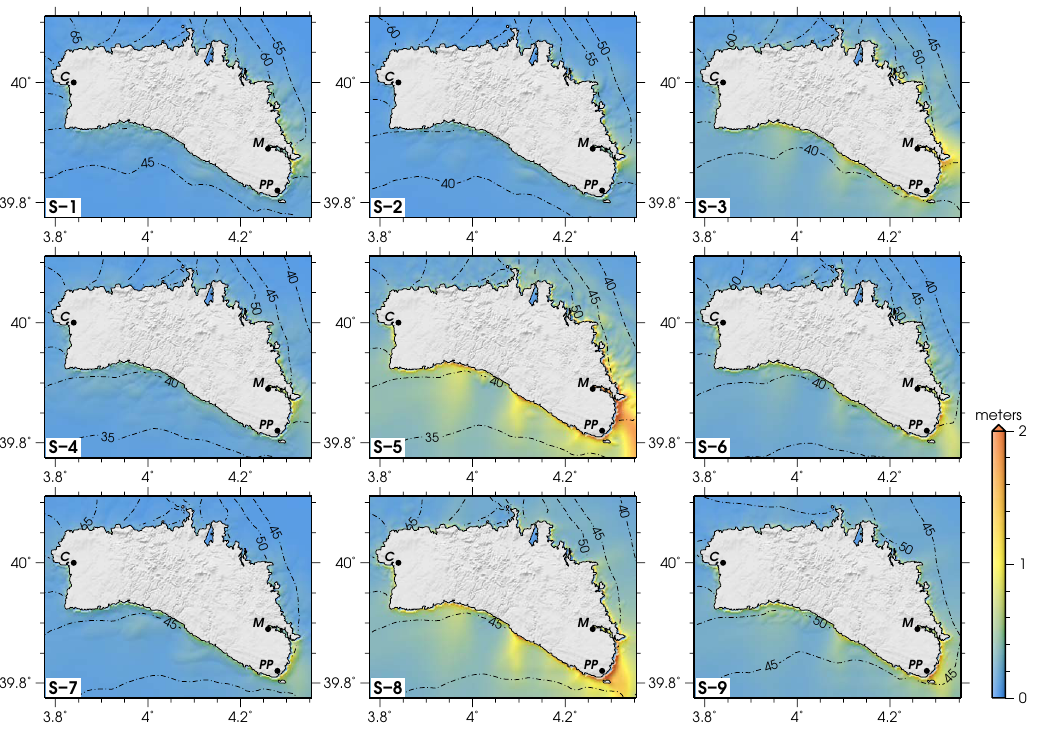
Fig. 8. Maximum wave elevation maps and estimated tsunami travel times for the Minorca Island. The shading represents the wave elevation value as shown in the colour scale at the right. The contours show the tsunami travel time in 5min steps from the source. Black dots show the location of relevant populations: PP, Punta Prima; M, Mah´on; C, Ciutadella.